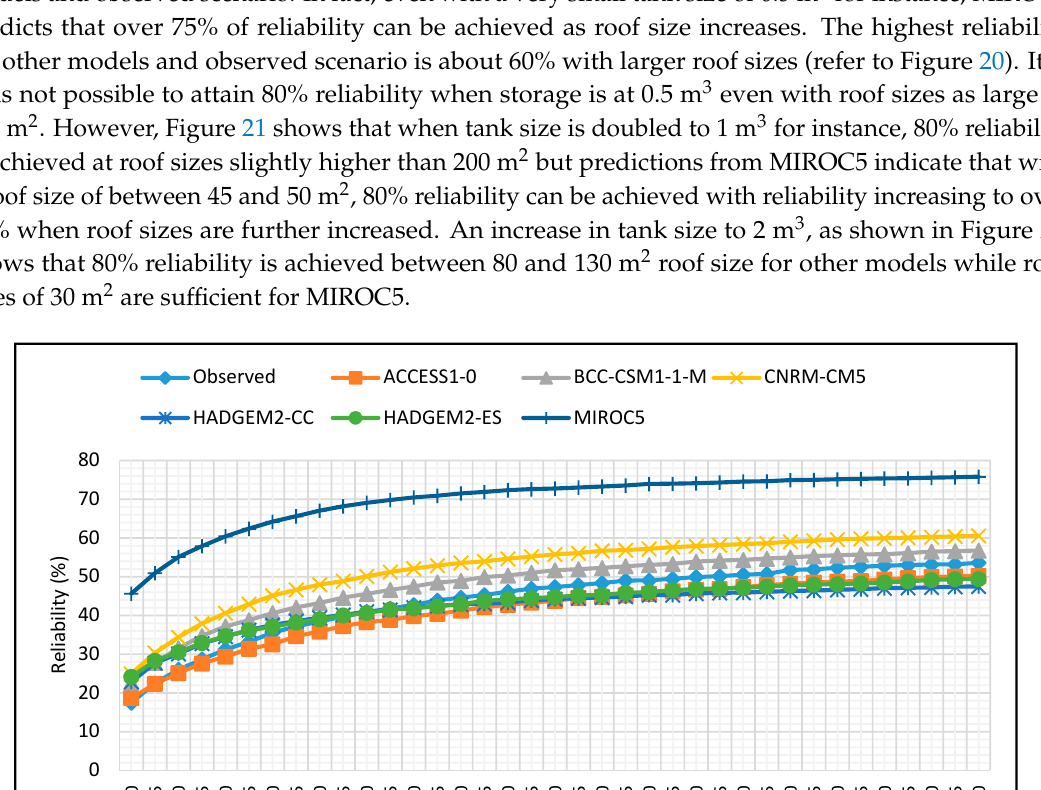
Figure 19. JJA showing change in reliability for 2060–2090 period for 5 m 3 .